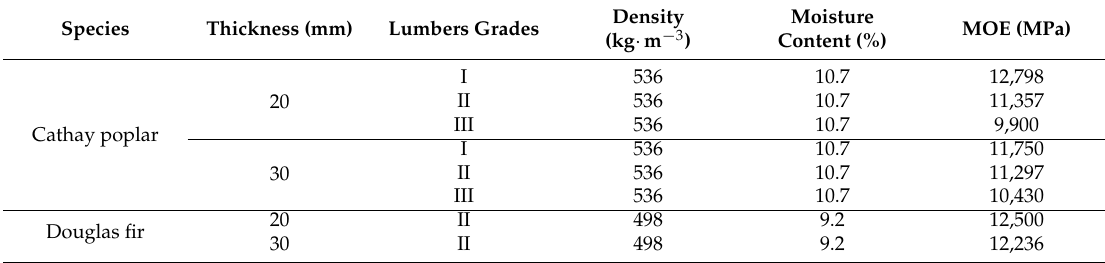
Table 1. Mean physical and mechanical properties of the lumber investigated in this